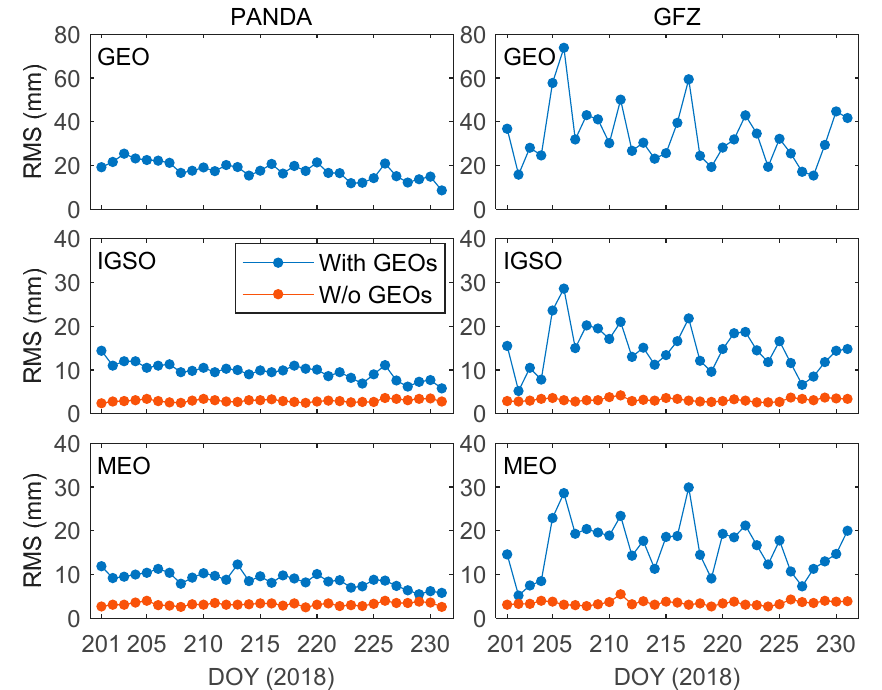
Figure 11. Post-fit residual RMS of BDS carrier phase of each POD arc. The left panels show the residuals based on PANDA BDS products; the right panels show the residuals based on GFZ BDS products. In both plots, the blue dots represent the approach with GEO satellites and the red line is the approach without GEO satellites.